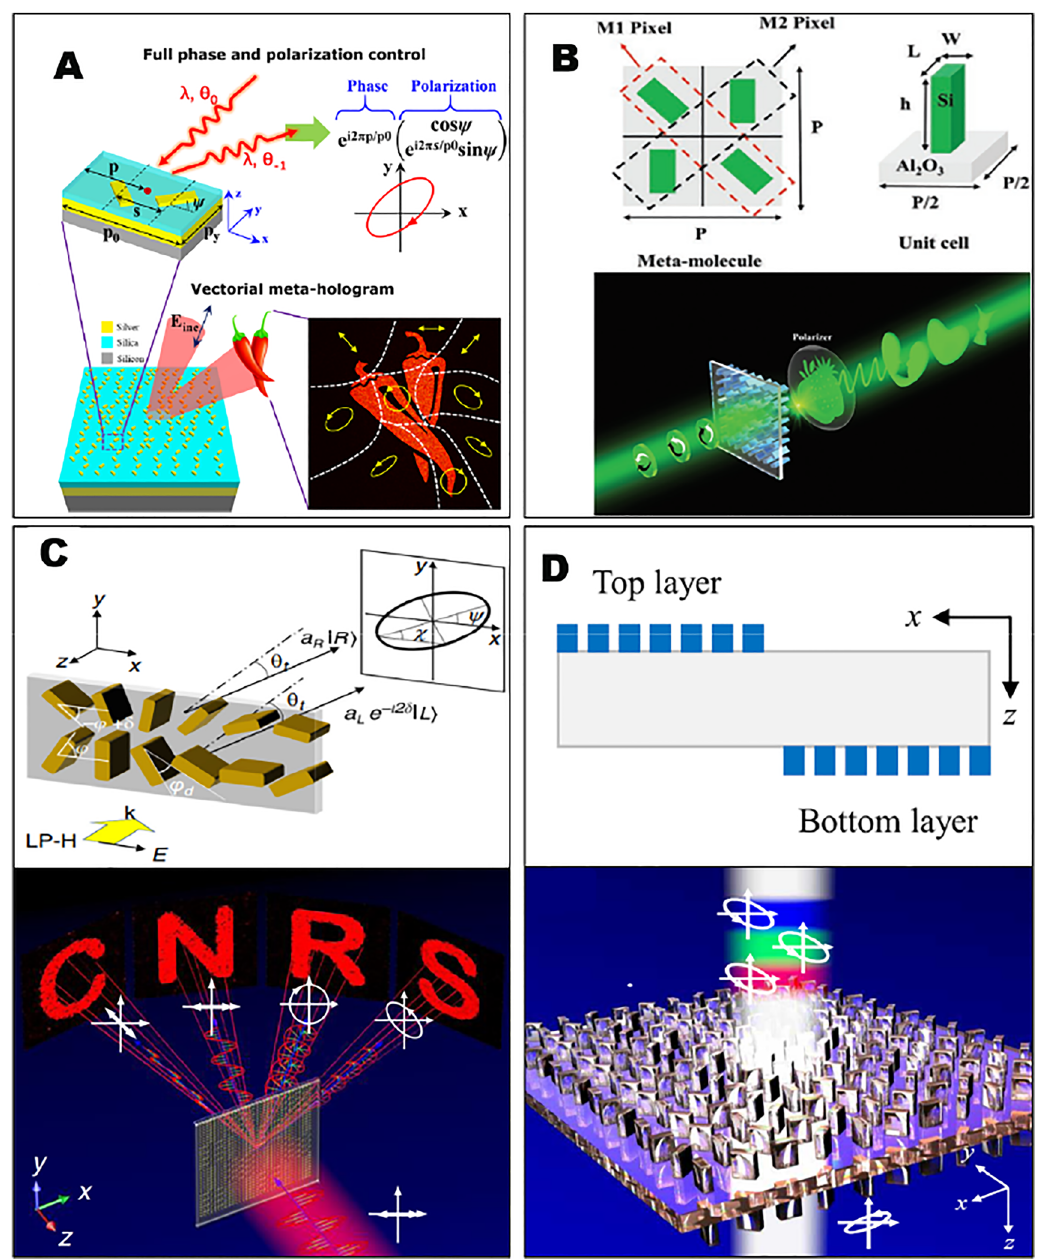
Figure 1: Multi-atomic metasurfaces for vectorial holography.